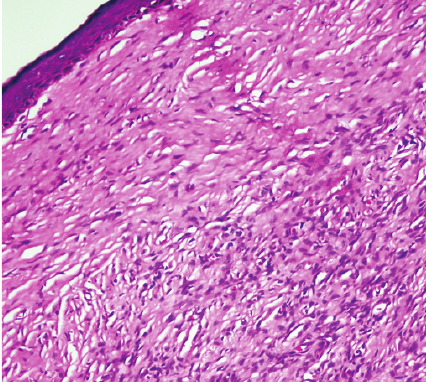
Figure3:Inthepathologypreparate,spindle-shapedfibroblastsand bundles of short crossing myofibroblasts are observed (HE